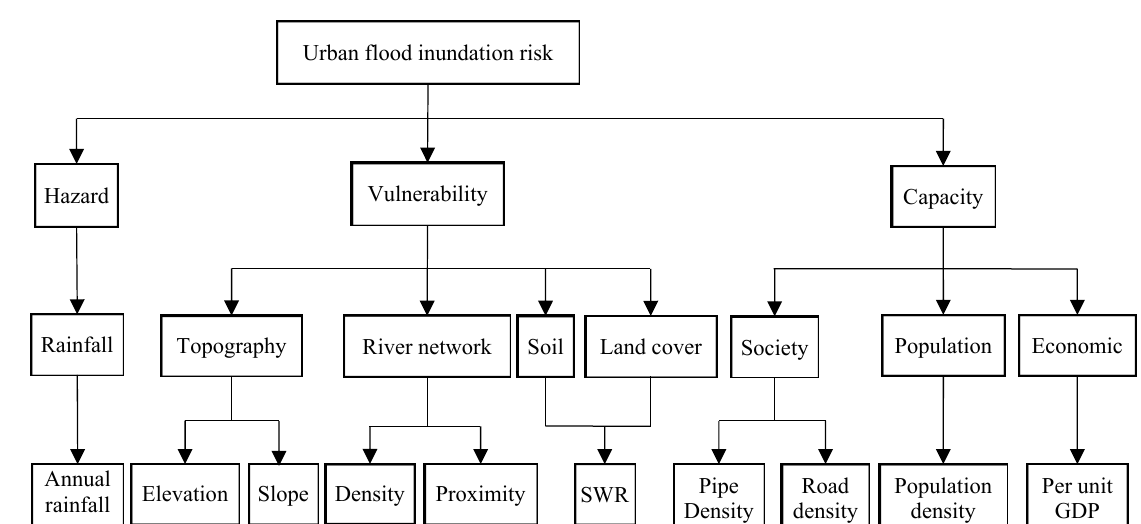
Figure 2. Influencing factors of urban flood inundation risk.